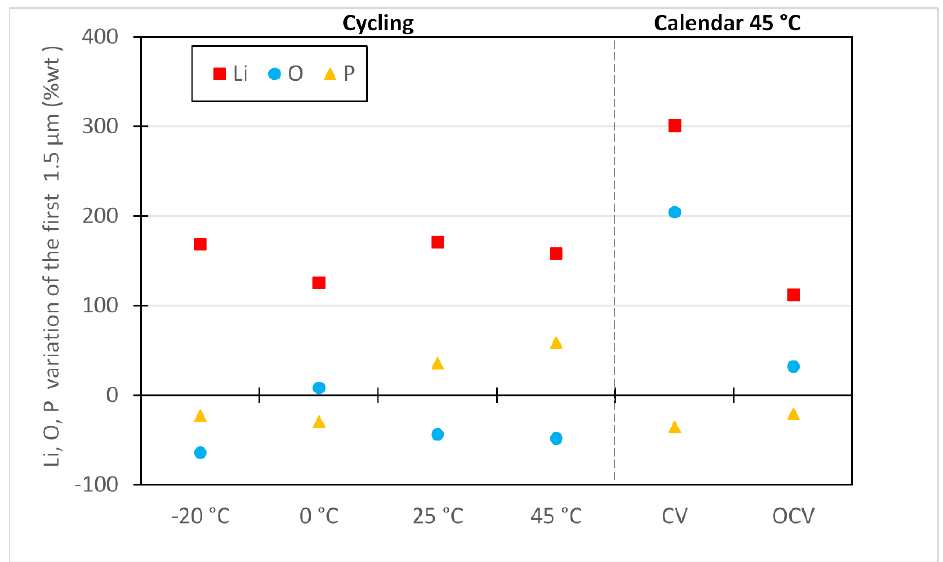
Figure 7. Relative variation compares to fresh cell of Li, O, and P in the 30Q negative electrode surface after aging as measured by GD-OES depth profiling.